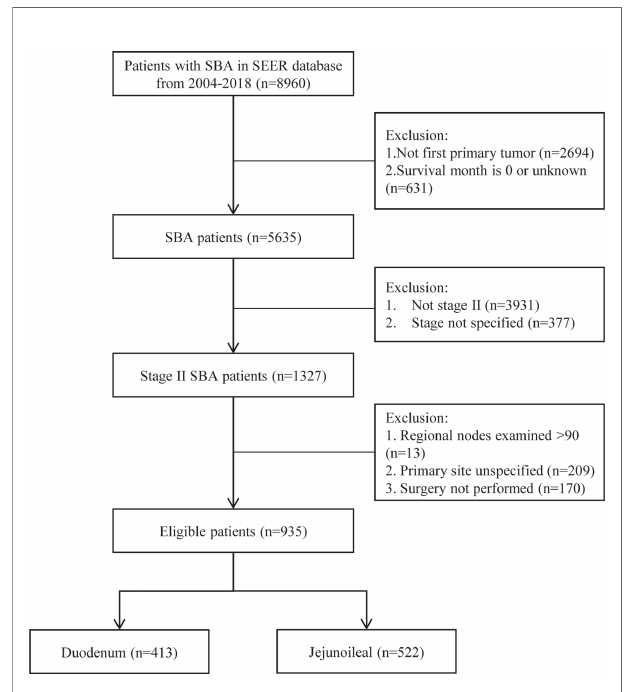
FIGURE 1 | Flowchart demonstrating the selection processes of cases from SEER database used in this analysis. SBA, small bowel adenocarcinoma; SEER, Surveillance, Epidemiology, and End Results